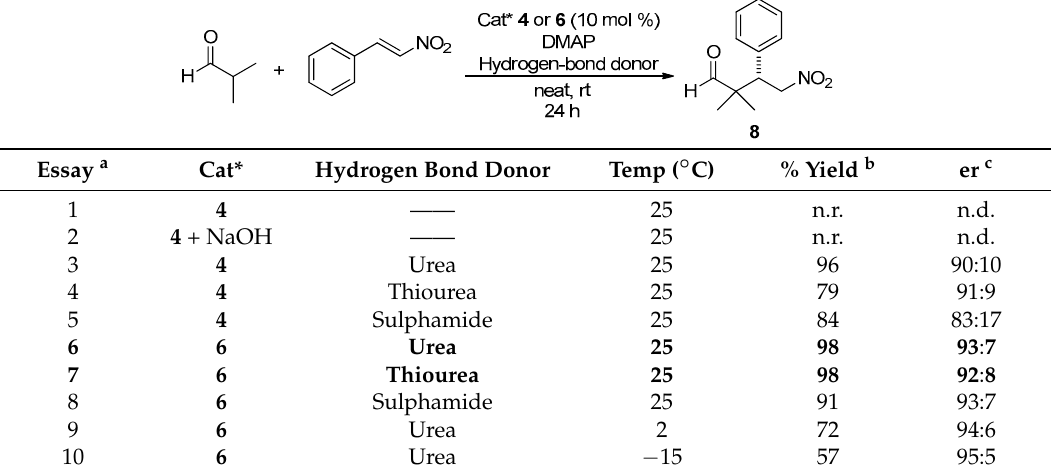
Molecules 2017 , 22 , 1328 Table 7. Michael addition reaction of isobutyraldehyde to trans - β -nitrostyrene organocatalyzed by dipeptides 4 and 6 in the presence of different hydrogen bond donors and at various temperatures.